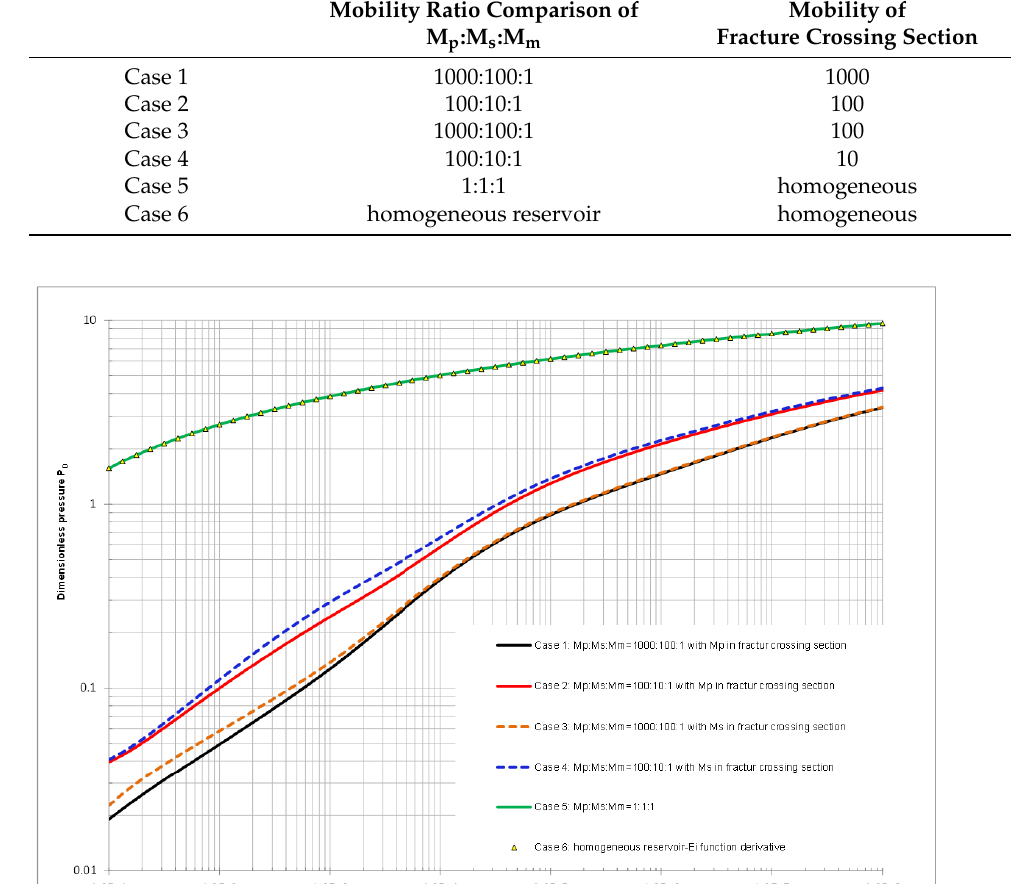
Figure 26. dP D /d(lnt D ) responses for the six cases based on the simplified fracture network model.